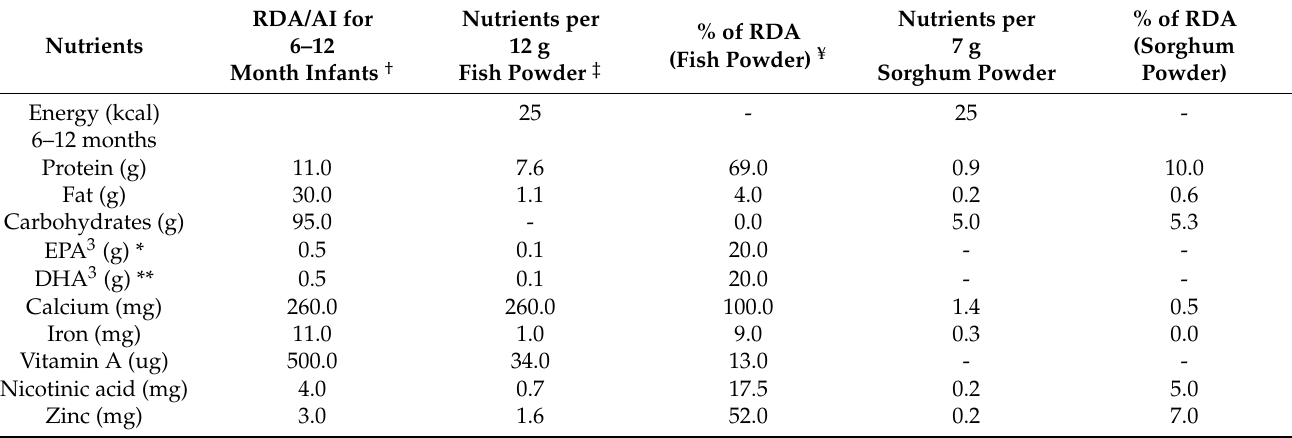
Table 2. The nutrient content of the daily dose of fish, sorghum and their contribution to the